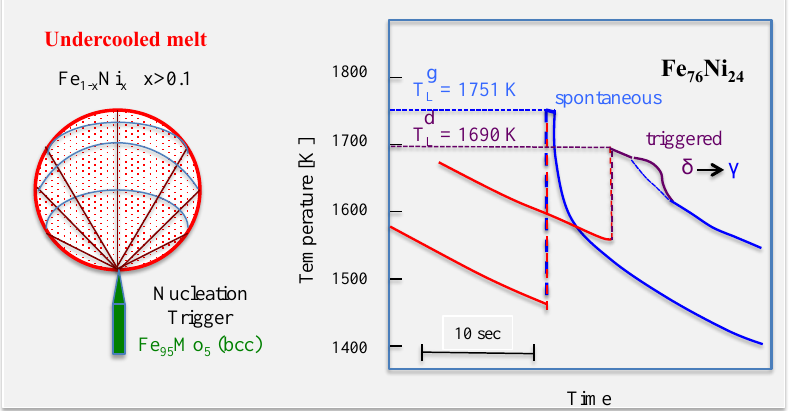
Ni 76 24 Mo bcc phase. ( Right ) Two 95 5 Ni alloy. 76 24 Mo nucleation trigger (green 95 5